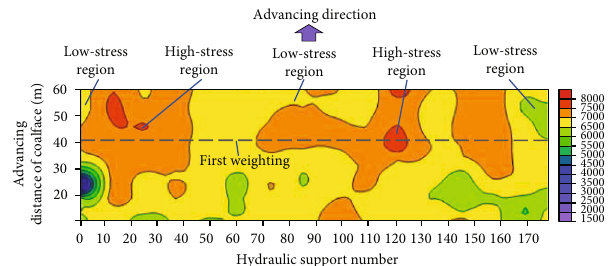
Figure 10: Distribution characteristics of the daily average working resistance of hydraulic supports during primary